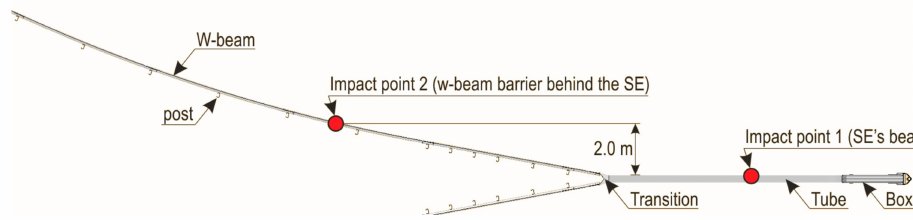
Figure 9. Setup of parametric